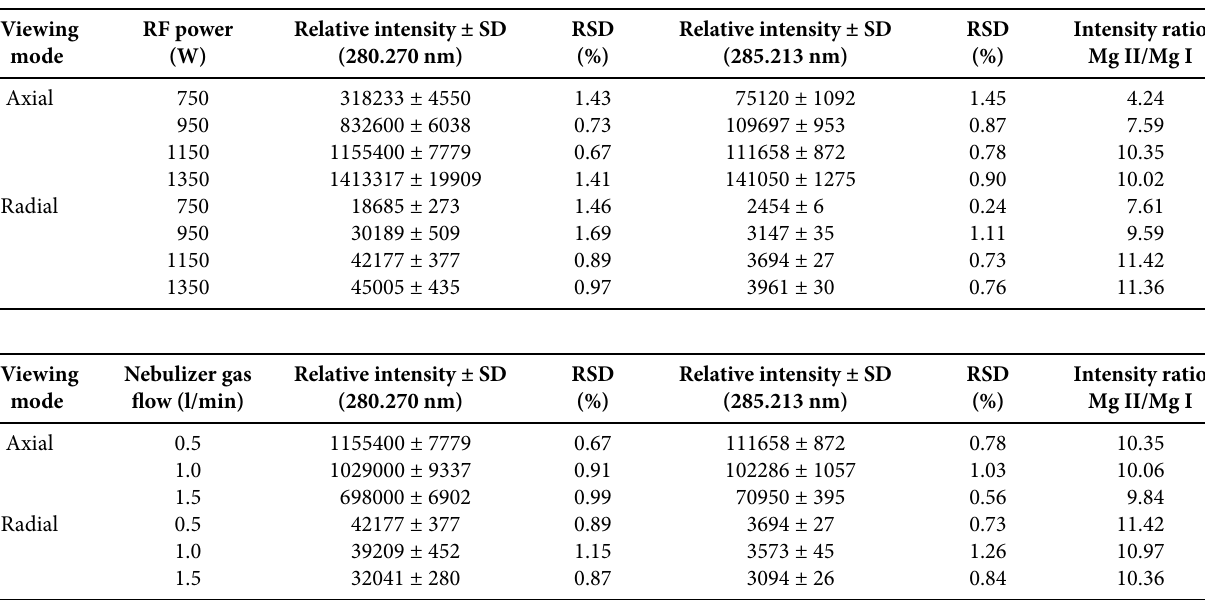
Table 1. Results (mean ± SD, n = 3) obtained for RF power and nebulizer gas flow rate in axial/radial mode